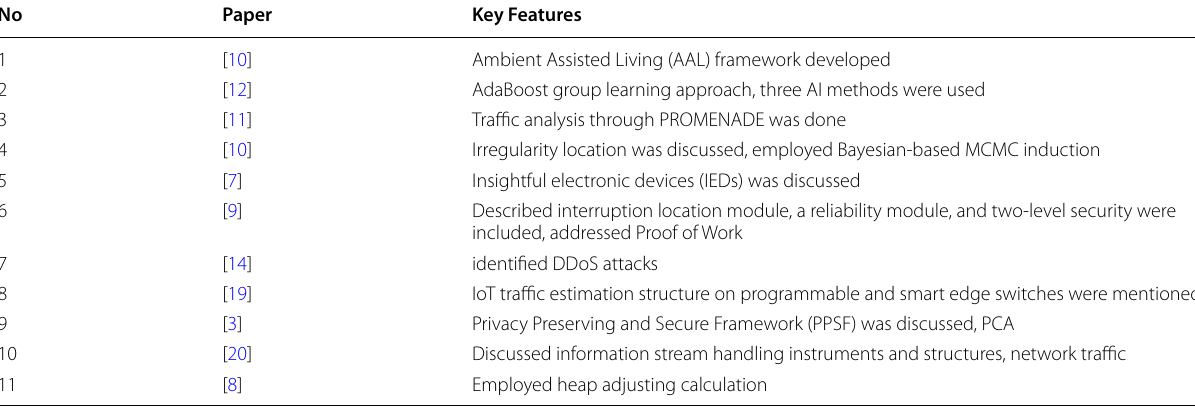
Table 1 Related Work